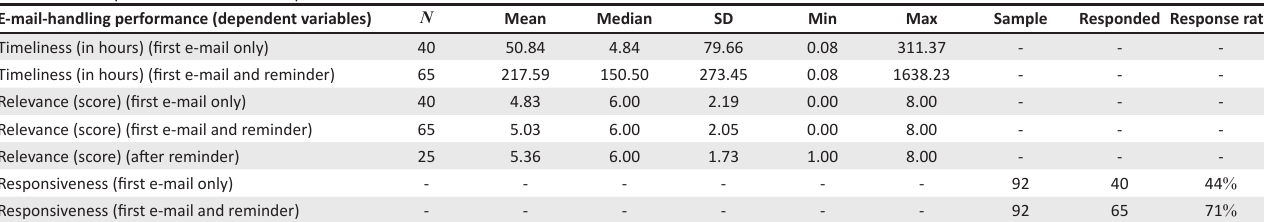
TABLE 3: Descriptive statistics of the dependent variables. E-mail-handling performance (dependent variables) N Responded Response